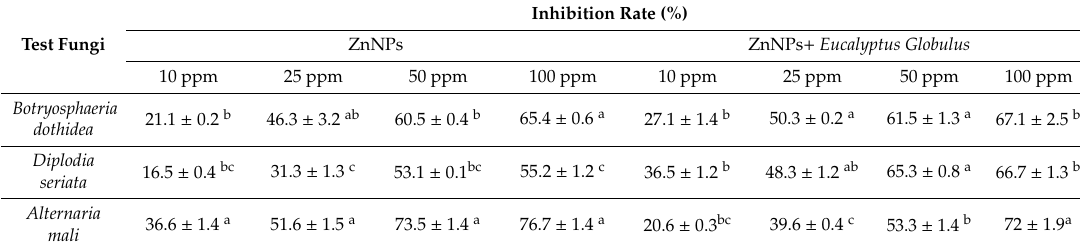
Table 2. In vitro inhibitory rate (%) of phytopathogenic fungi using di ff erent concentrations of synthesized ZnNPs alone and synergistic ZnNPs plus Eucalyptus globulus leaf